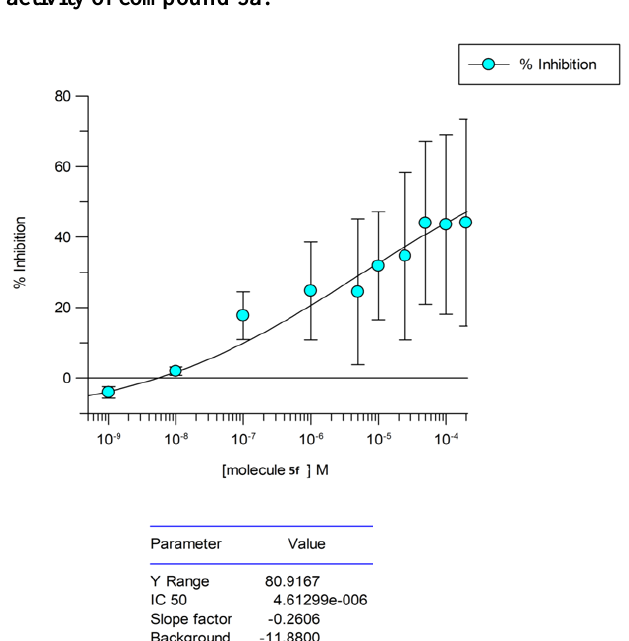
Figure 3 . Alpha glucosidase inhibitory activity of compound